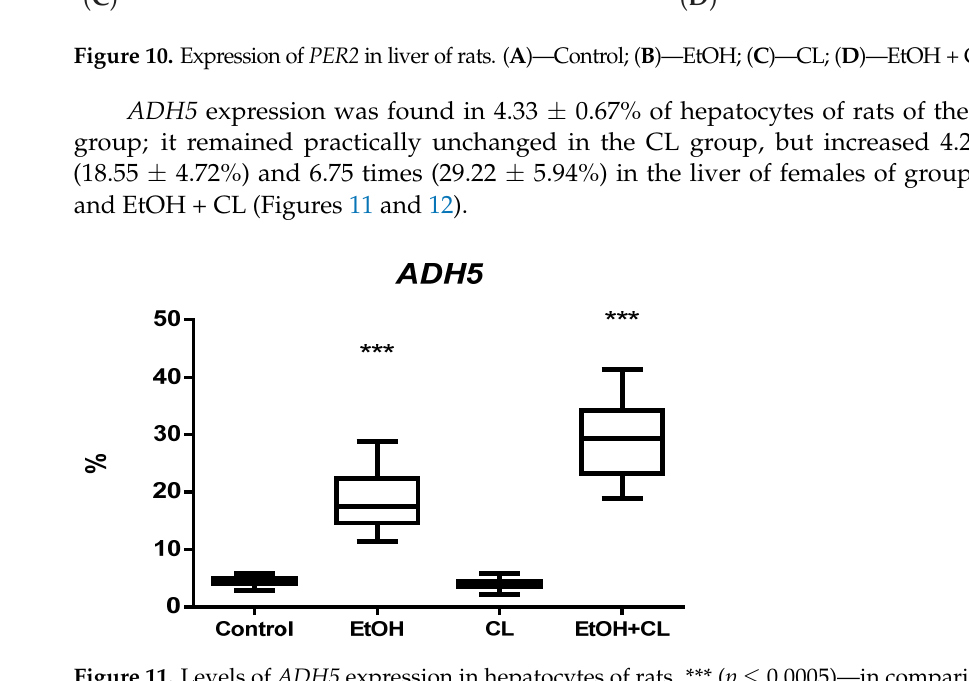
Figure 10. Expression of PER2 in liver of rats. ( A )—Control; ( B )—EtOH; ( C )—CL; ( D )—EtOH+CL. ×200.